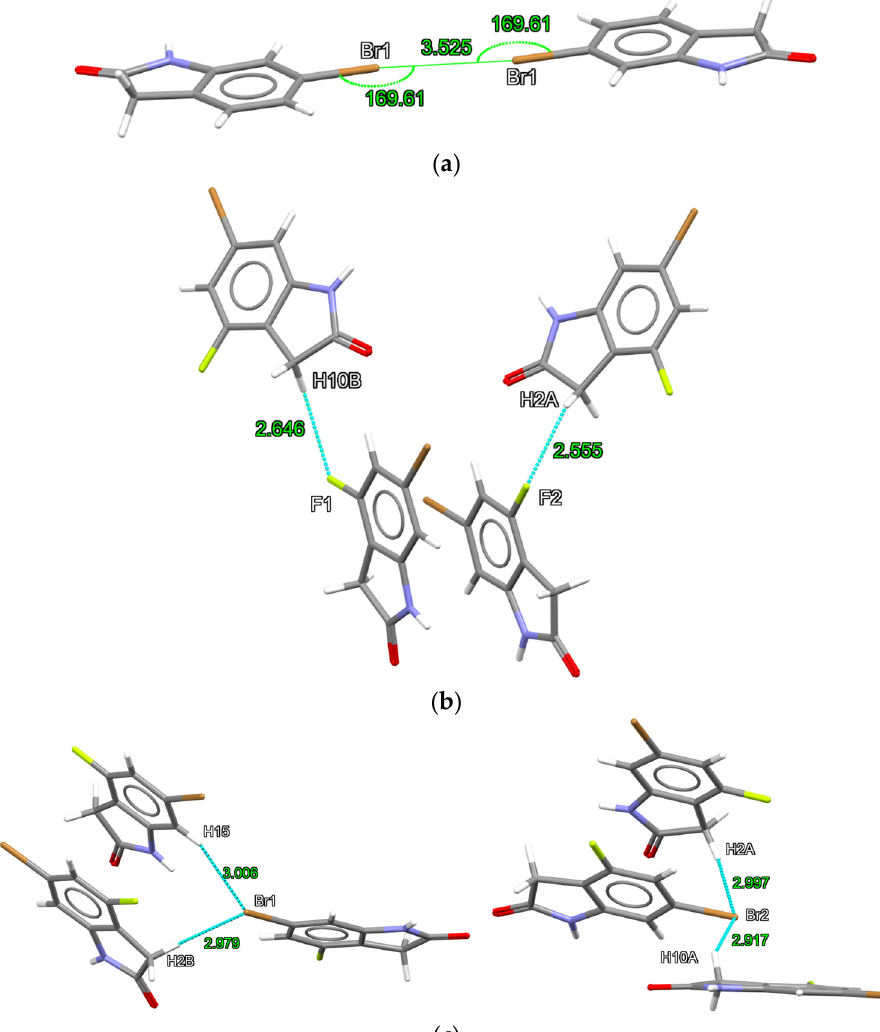
Figure 3. Short intermolecular contacts involving halogens in 1 ( a ) (Br ··· Br), 2 ( b ) (C-H ··· F), and 2 ( c ) (C-H ··· Br). Intermolecular atom ··· atom distances in units of Å, angles in degrees. Each fluorine of 2 has a short intermolecular contact with a methylene C-H. Each bromine of 2 has two short contacts, one with two unique methylene C-H and the other with one methylene C-H and one aromatic C-H. These new interactions may result from increased ability of the methylene hydrogens to act as C-H donors induced by the electron- withdrawing nature of the β carbon fluorination. Aromatic and methylene C-H ··· O contacts are present in 1 and 2 but this C-H ··· O interaction in 2 is paired with the methylene C-H ··· F interaction in an R 2,2(8) motif (Figure